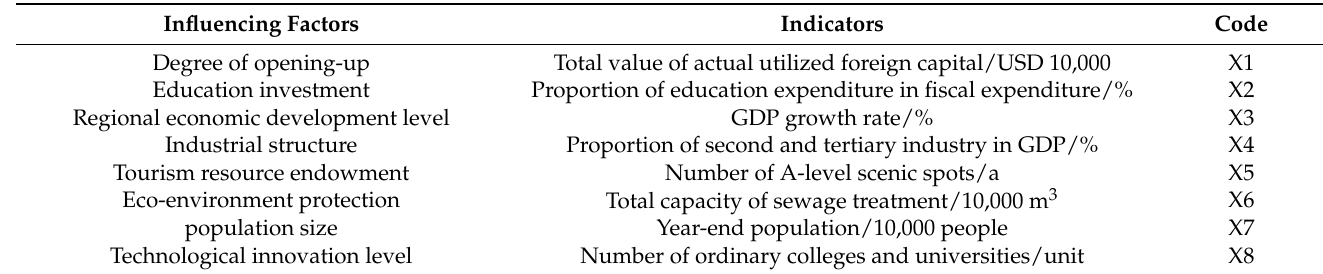
Table 3. The influencing factors of CCD of the TEE system in